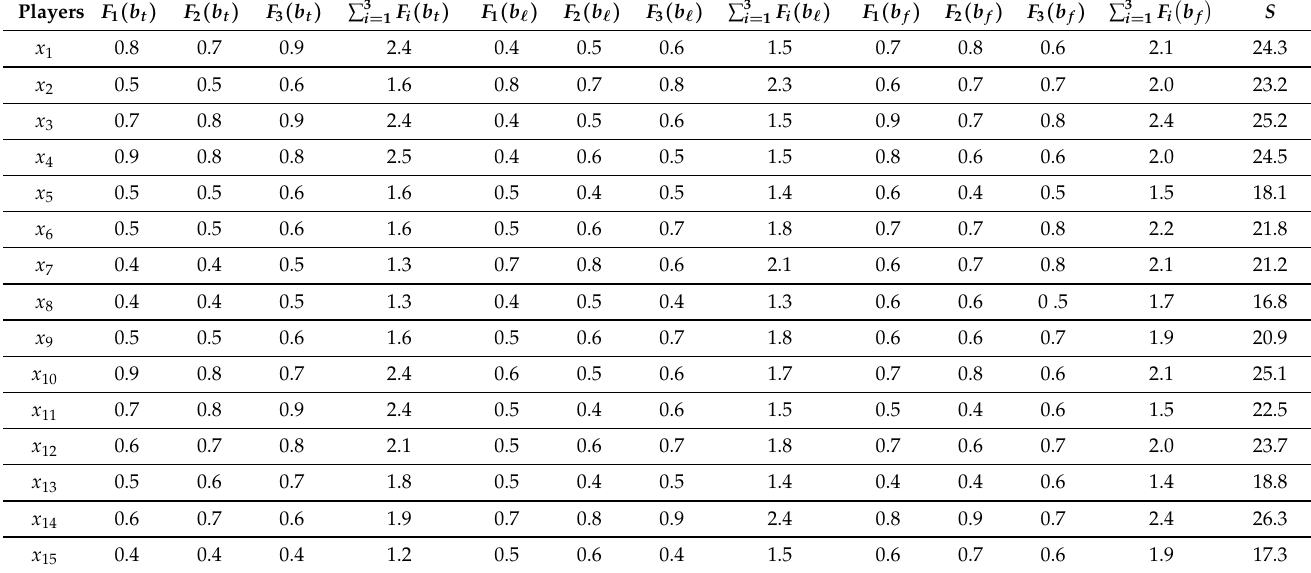
Table 1. Opinion polls of the coaches.